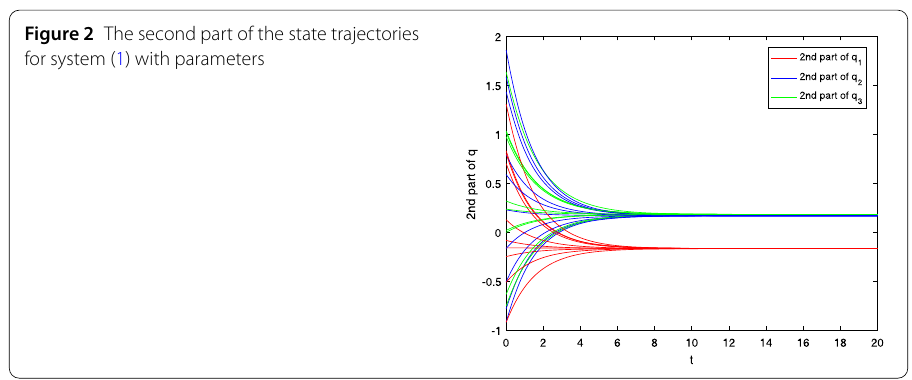
Figure 3 The third part of the state trajectories for system (1) with parameters